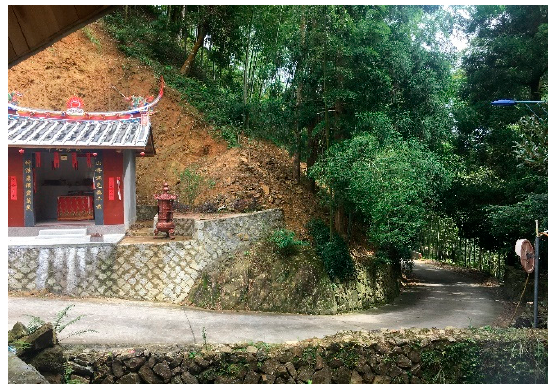
Figure 5. Temple of the earth god in Kengtou Village.